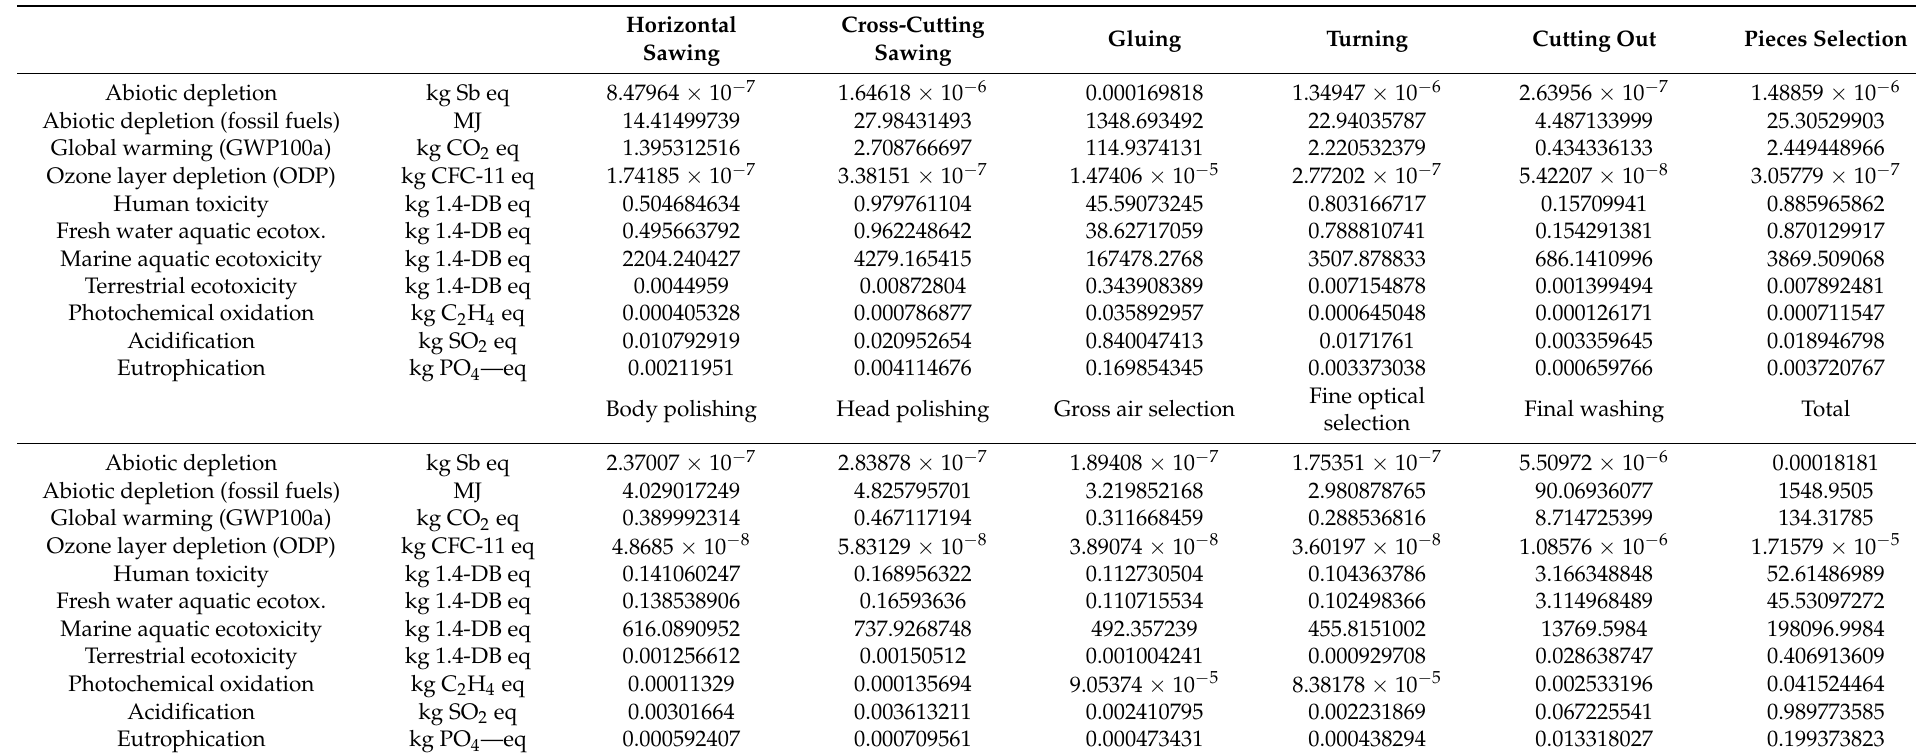
Table 13. Impact of stage 2 broken down by activities for the manufacturing process of 2-piece turned stoppers of 26 mm diameter and 44 mm in length. Horizontal Cross-Cutting Sawing